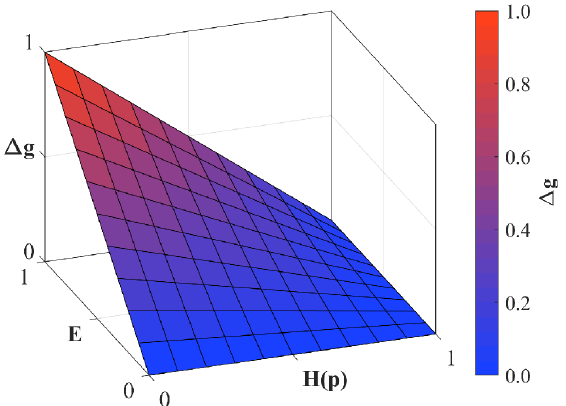
Figure 10. Graphical interpretation of the relation between erosion force, materials’ hardness, and their influence on the results of the gradation